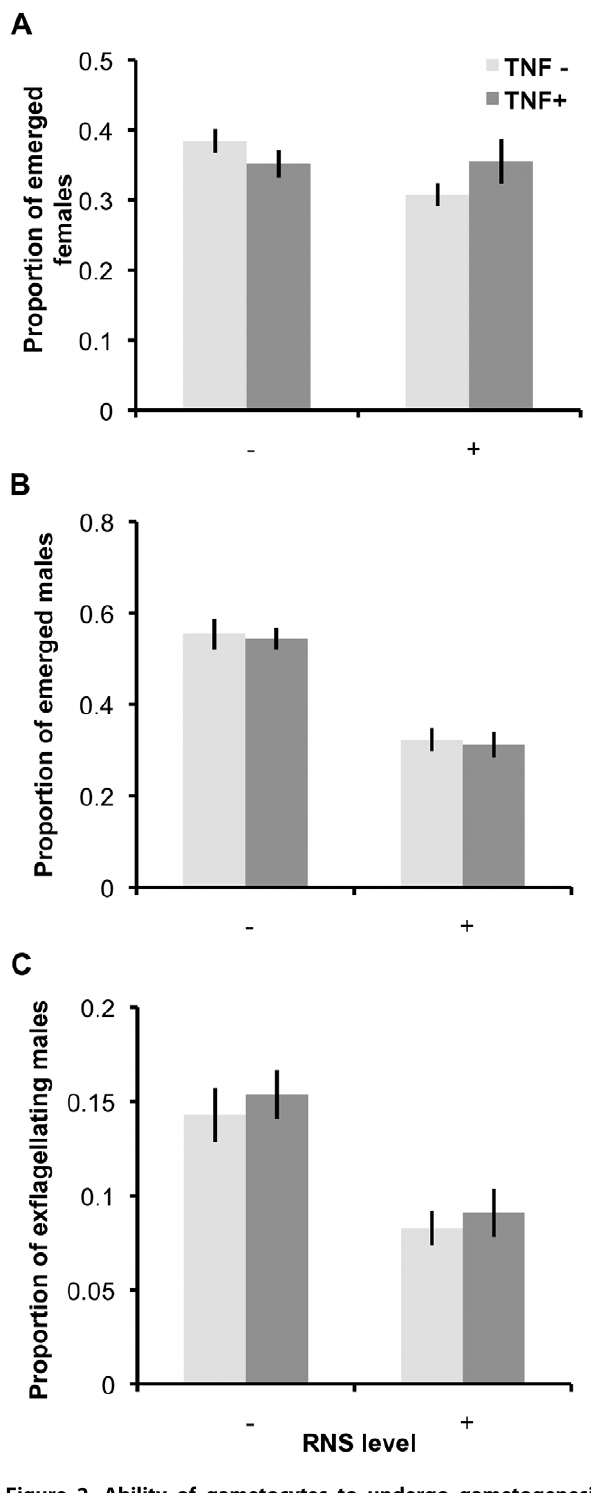
Figure 2. Ability of gametocytes to undergo gametogenesis after exposure to RNS and TNF- a . Mean ( 6 S.E.) proportion (n=20) of emerged female gametes (A), emerged male gametocytes (B), and exflagellating male gametes (C), relative to the total number of male or female gametocytes/gametes observed, when gametocytes are ex- posed to immune factors during incubation in ‘host conditions’ and then activated in un-manipulated ‘vector conditions’ media.